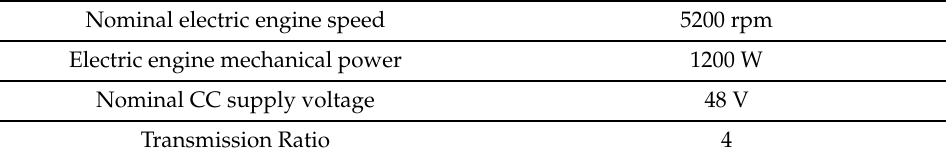
Table 2. Electric motor data.